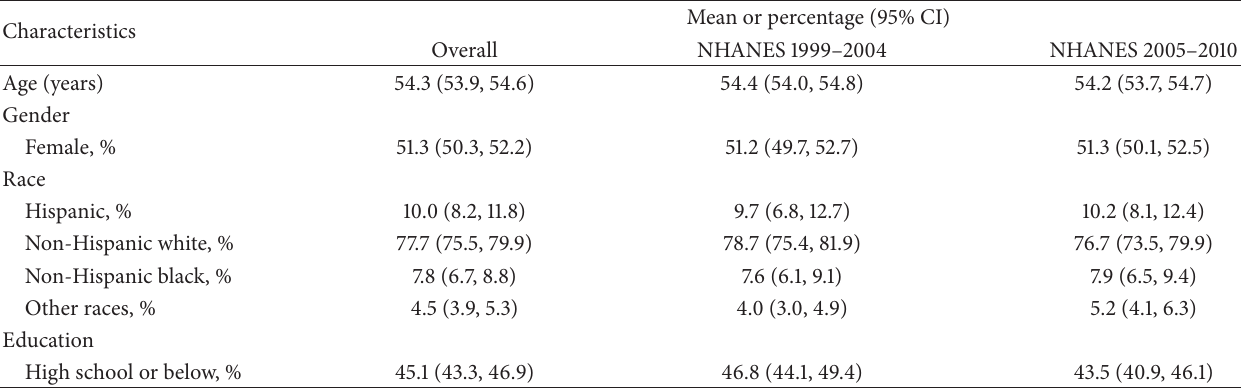
Table 1: Characteristics of participants in NHANES 1999–2010, USA.